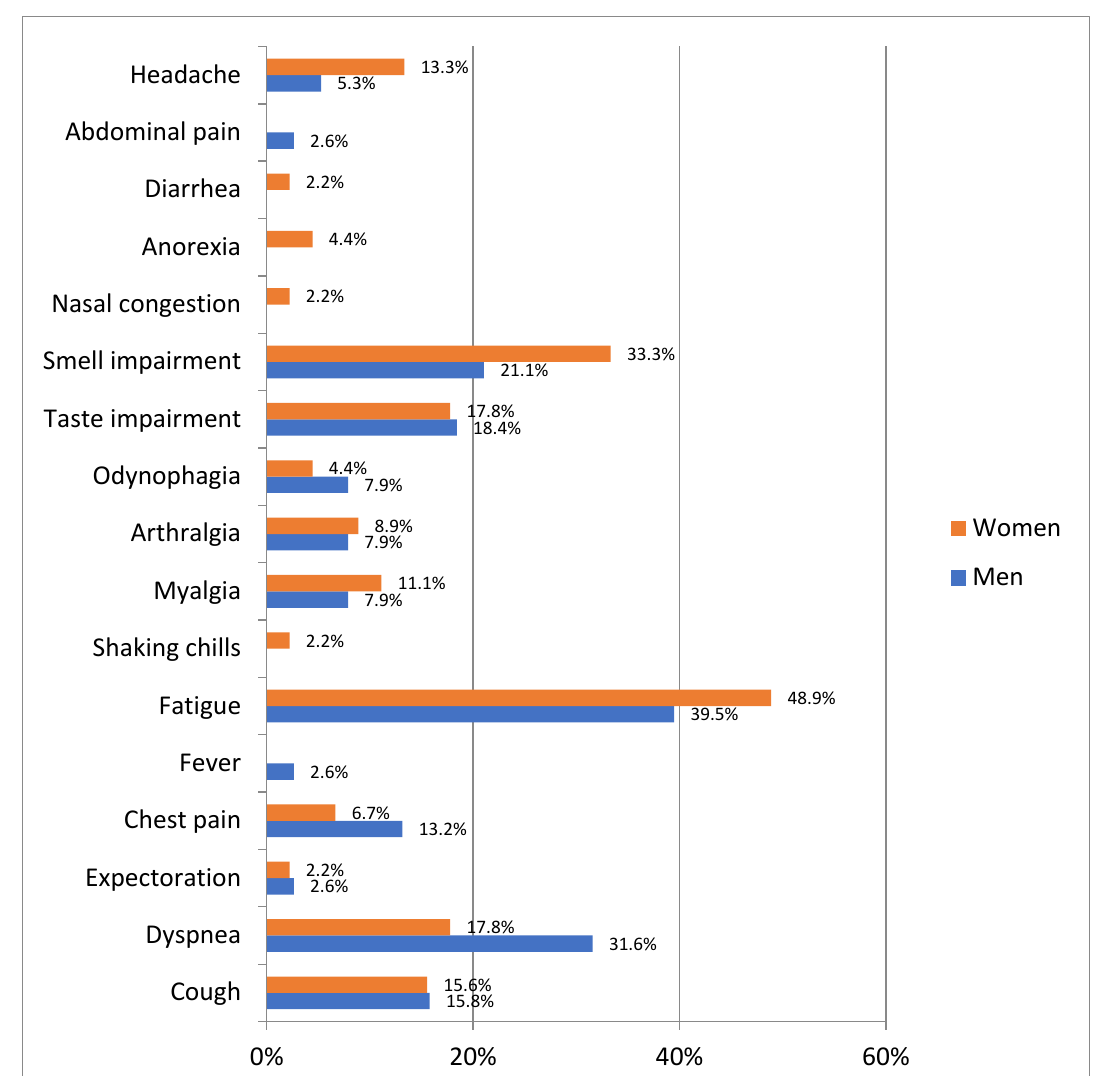
Figure 1. Prevalence of persistent symptoms among patients with post COVID ‐ 19 condition by gender ( n = 83).